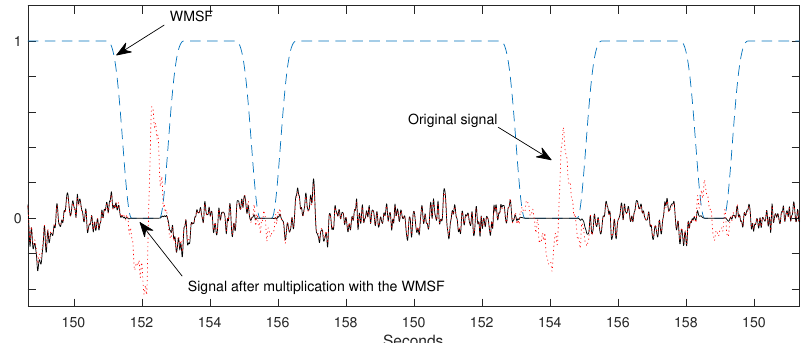
Figure 7. Example of the application of a WMSF to a signal component.